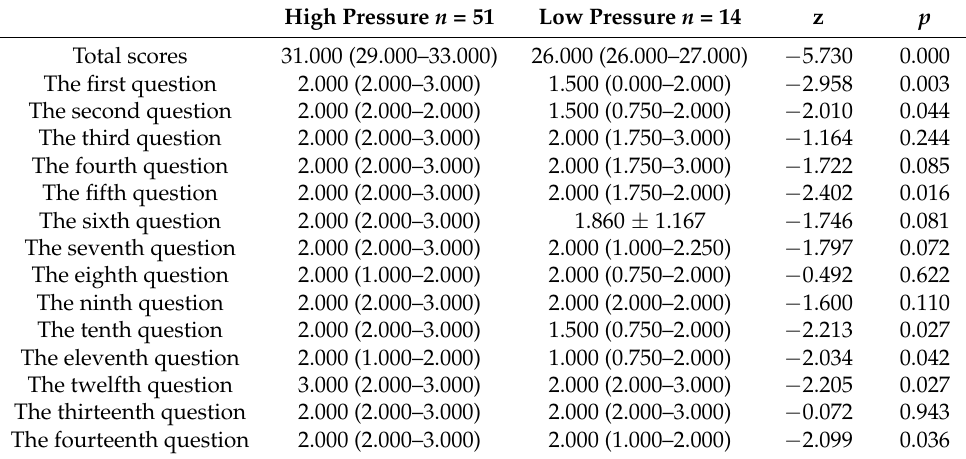
Table 1. Results of the first PSS-14 questionnaire survey.